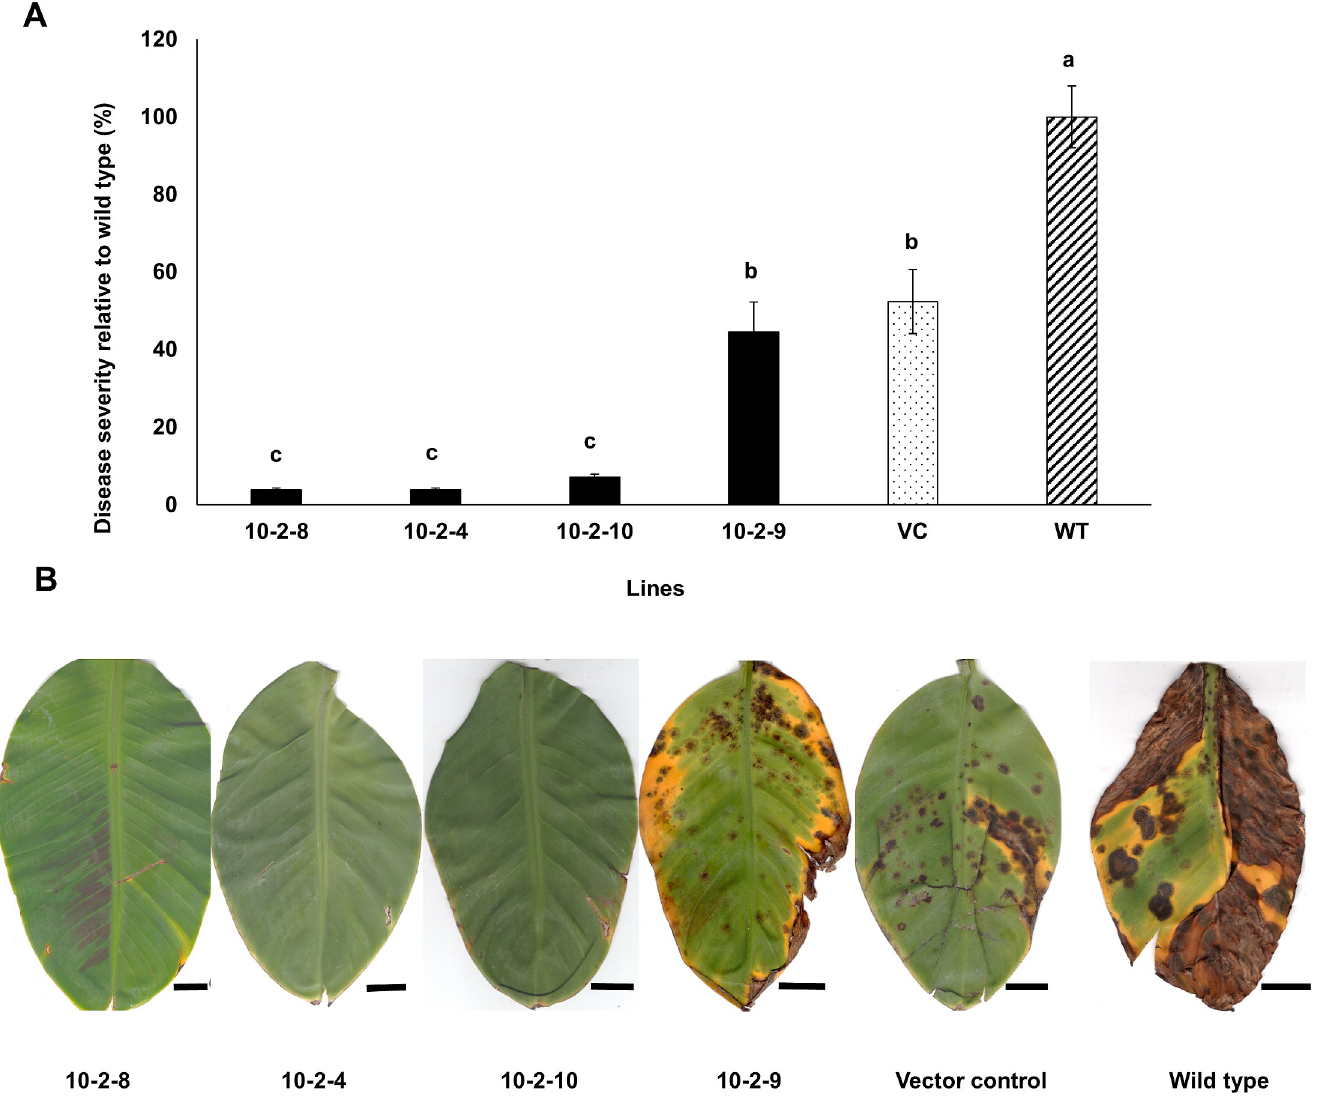
Fig 9. Black Sigatoka disease development in banana inoculated with wild type, vector control, and transformants silenced with the PKS10-2 silencing construct. A) Black Sigatoka disease response as seen in banana plants 9 weeks after inoculation with the wild type (hatched bar), vector control (dotted bar) and silencing transformants (dark bars). Disease severity caused by each isolate was assessed by the Fiji ImageJ program and is shown relative to wild type isolate 10CR1- 24. Data shown are results of two independent experiments with 8 plants per strain in each experiment. The within-group differences between the different PKS10-2 silencing transformants, vector control, and wild type isolate were examined using ANOVA with Bonferroni post hoc test for multiple comparisons. Bars represent Mean ± SE. Different letters on bars indicate statistically significant differences ( p � 0.05). B) Symptoms on banana plants inoculated with PKS10-2 silencing transformants 10-2-8, 10-2-4, 10-2-10, and 10-2-9 as compared to symptoms on banana inoculated with the vector control and wild type isolate 10CR1-24. Scale bar represents 1 inch.